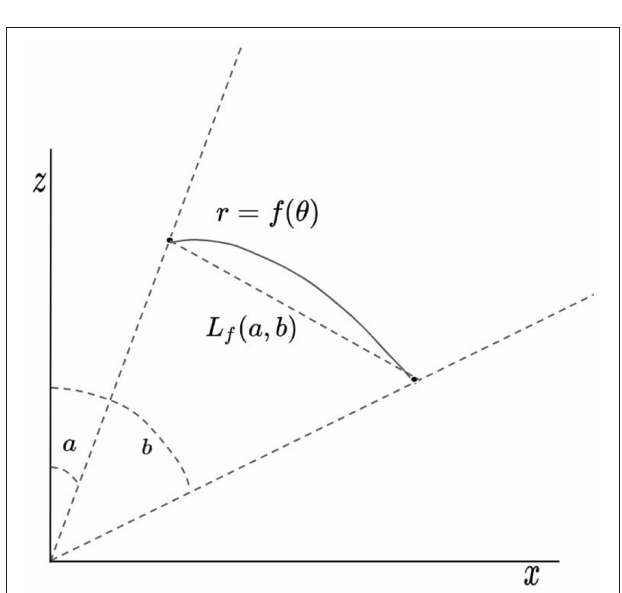
FIGURE 7 | This diagram illustrates the meaning of the criterion D n ( f ) ≤ ˜ χ . D n ( f ) is the length of the shortest possible chain given the choice of f ( 2 n + 1 ) = C n + 1 . If D n ( f ) > ˜ χ , it is not possible to construct a chain having total length ˜ χ that connects the end